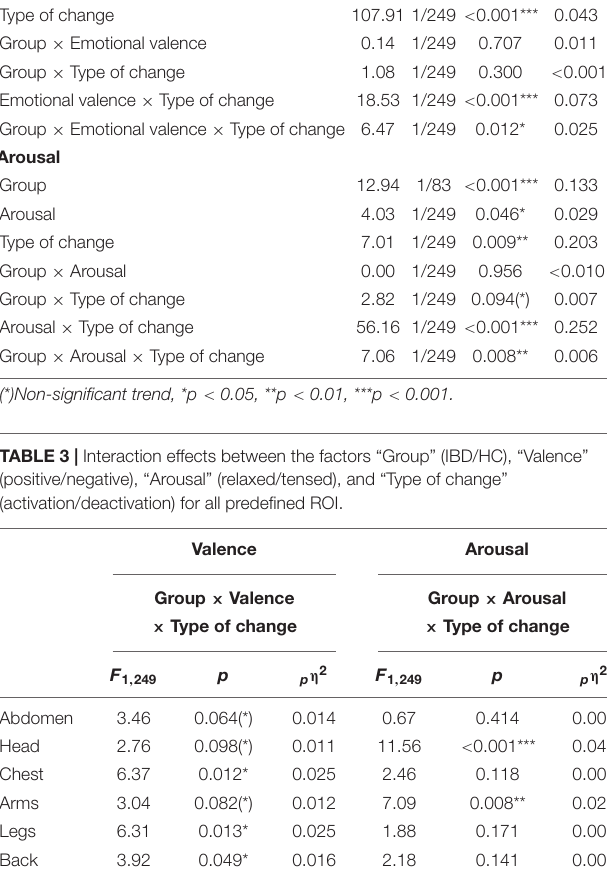
and data ranges for these conditions are shown in Figure 3 F df